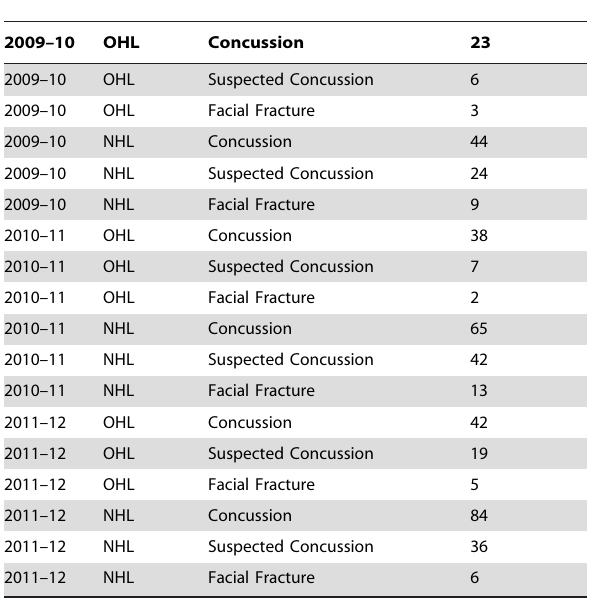
Table 1. Concussions in the OHL and NHL.